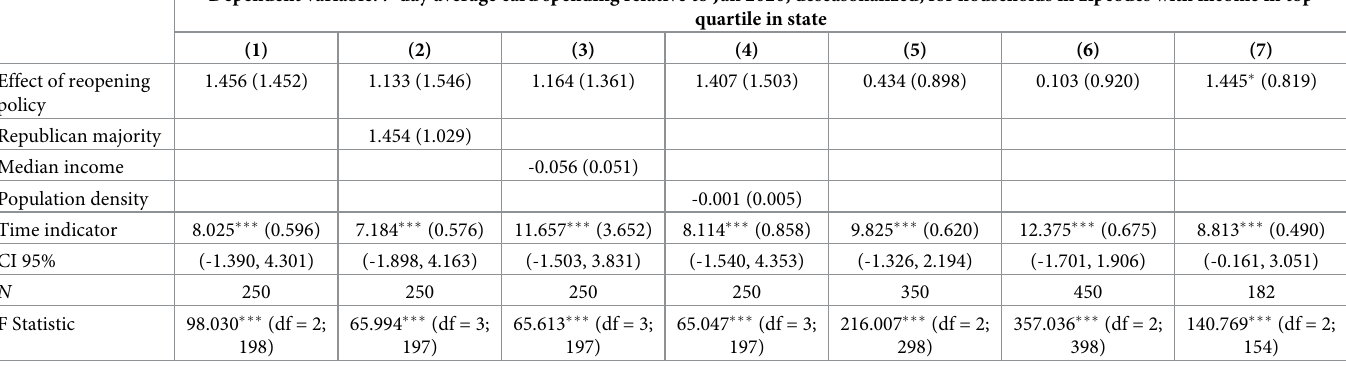
Table 2. Difference-in-differences model results for card spending in high-income